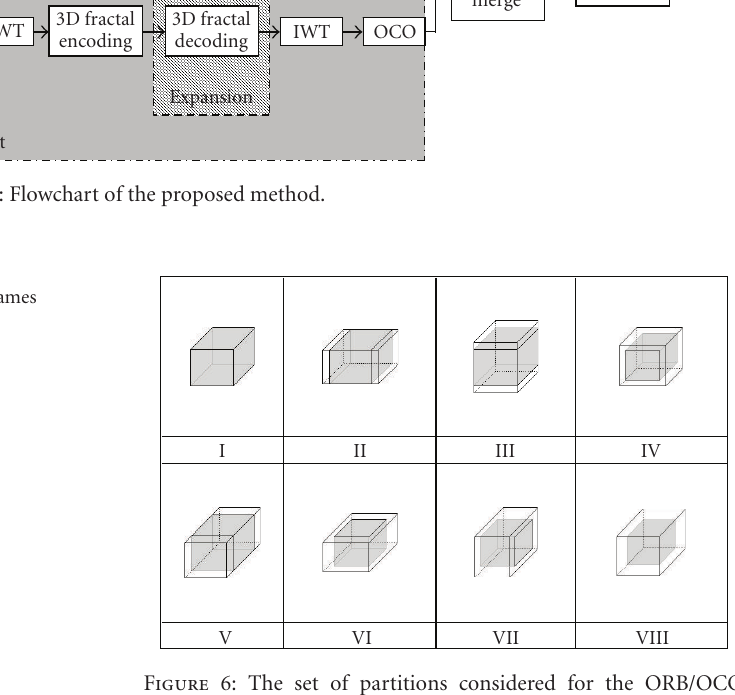
Figure 6: The set of partitions considered for the ORB/OCO